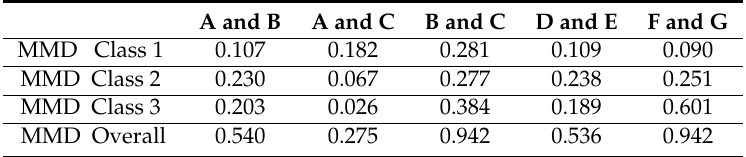
Table 2. Data drift